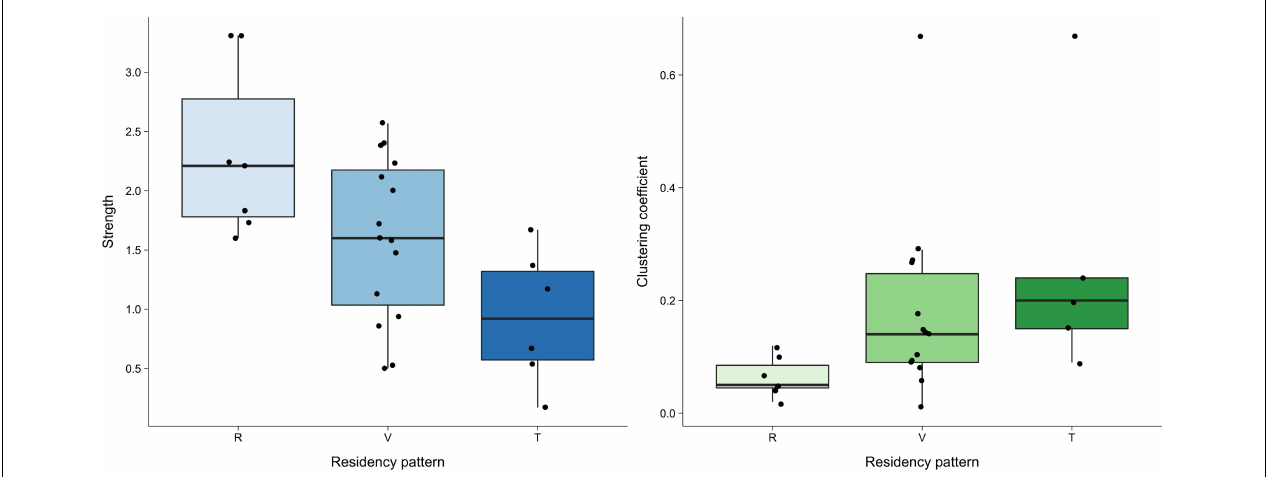
FIGURE 4 | Boxplot for strength and clustering coefficient for each residency pattern (R–resident, V–visitor, T–transient) in adult females (the most representative group). The horizontal line in the box represents the median, the bottom and top of the boxes represent the first and third quartiles and whiskers show values within 1.5 times of the interquartile range from the boxes. Raw data are plotted as single points. A double permutation test showed no significant differences on the influence of residency patterns in the social network structure.